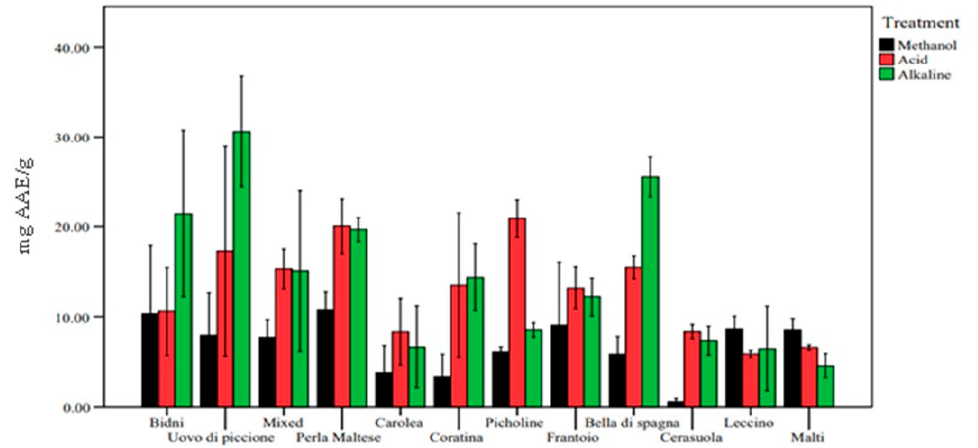
Figure 7. Mean of ferric reducing antioxidant activity of olive mill waste extracts using three different solvent extraction methods—methanol, acid and alkaline (black, red and green bars, respectively) with error bars showing ± 1SD for three independent trails.